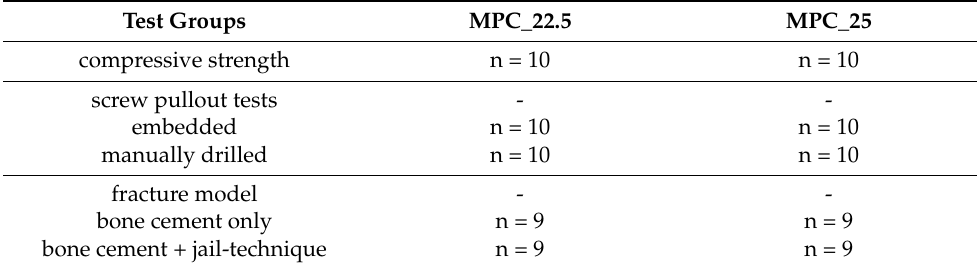
Table 2. Overview of the test groups and sample size n.